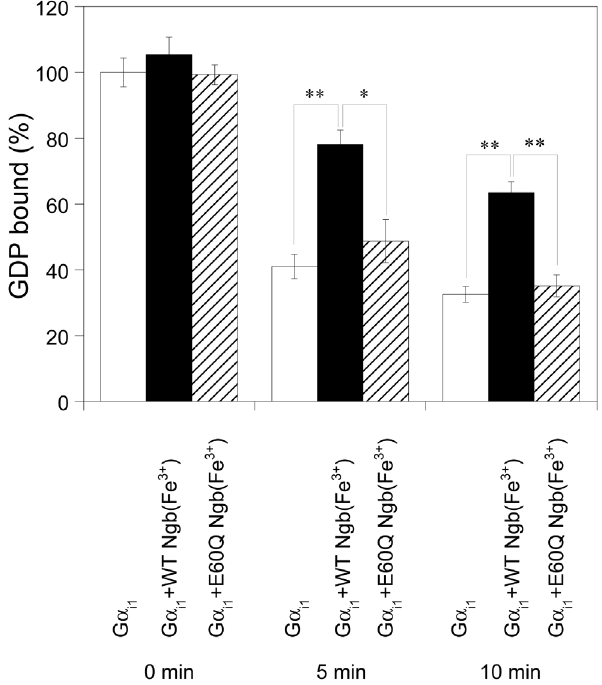
Figure 3. Effects of human WT Ngb or E60Q Ngb on the dissociation of GDP from human GDP-bound G a i1 . The amount of [ 3 H]GDP bound to G a i1 in the absence of human Ngb at 0 min was defined as 100%. All data are expressed as means 6 standard error of means (SEM) from four independent experiments. Data were analyzed by one-way ANOVA followed by Tukey-Kramer post hoc tests. *P , 0.05, **P , 0.01.